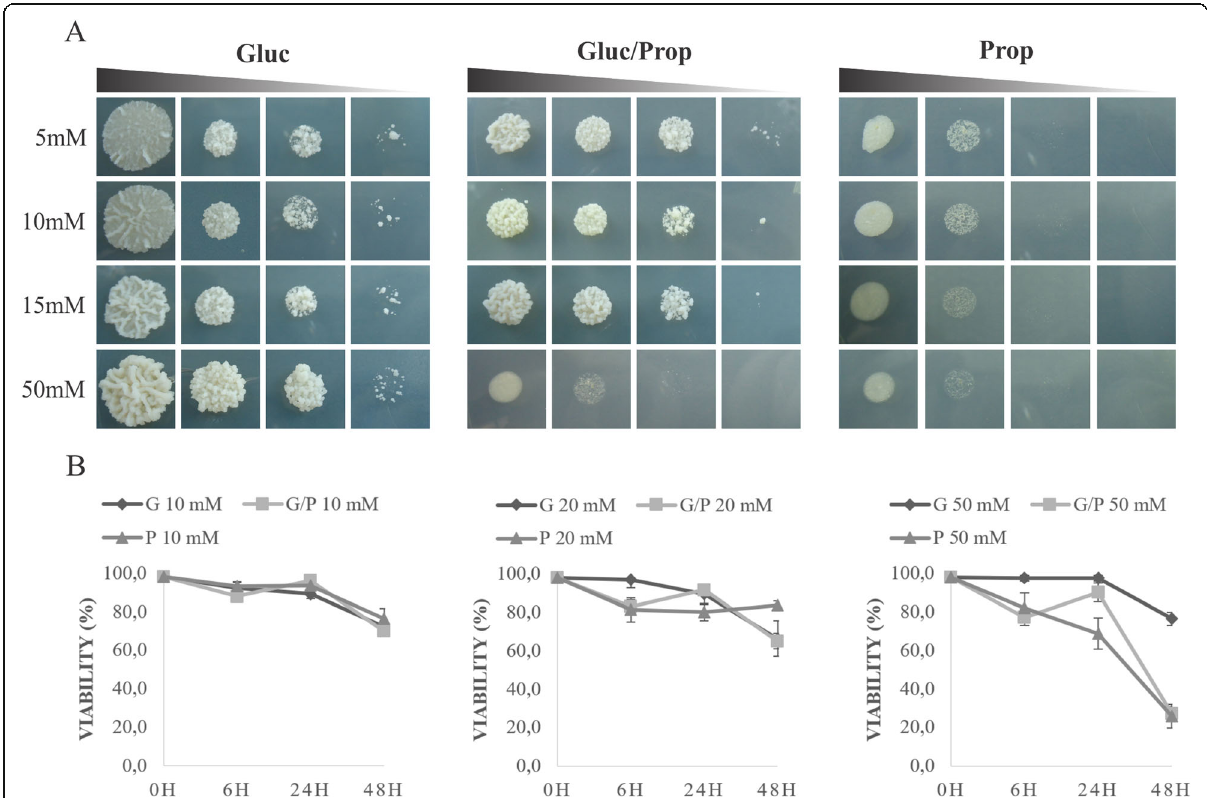
Fig. 1 Growth and survival analysis of P. lutzii on propionate. a Serial dilutions of cell suspensions (from 10 6 to 10 3 cells) were spotted on MMcM containing propionate, glucose plus propionate and glucose as carbon sources. The plates were incubated at 36 °C for 10 days. b Viability analysis of yeast cells incubated on MMcM medium containing propionate and/or glucose from 10 to 50 mM. Cell viability was assessed by using trypan blue. Error bars represent the standard deviation from the average obtained from independent biological triplicates